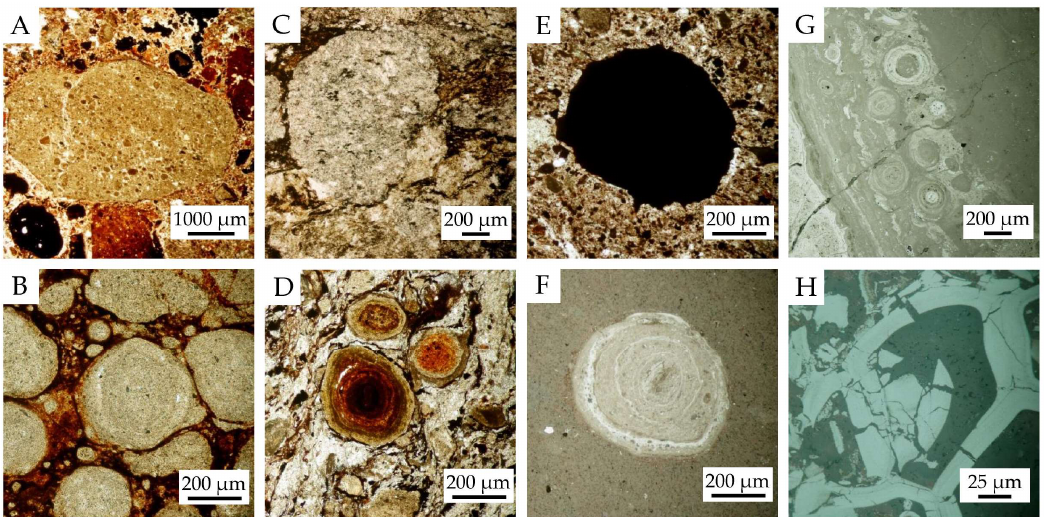
Figure 7. Transmitted, plane polarized ( A – E ) and reflected ( F – H ) light microphotographs of components and textures of the bauxite deposits from the CCR. ( A ) Bauxite roundgrains with local micro-ooids (<100 µm). ( B ) Detail of bauxite roundgrains. ( C ) Close-up of a bauxite clast made up of